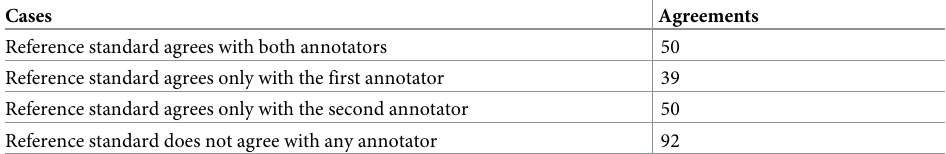
Table 4. Quantitative analysis of the agreements at chunk level between the reference standard with the two English annotators. Cases